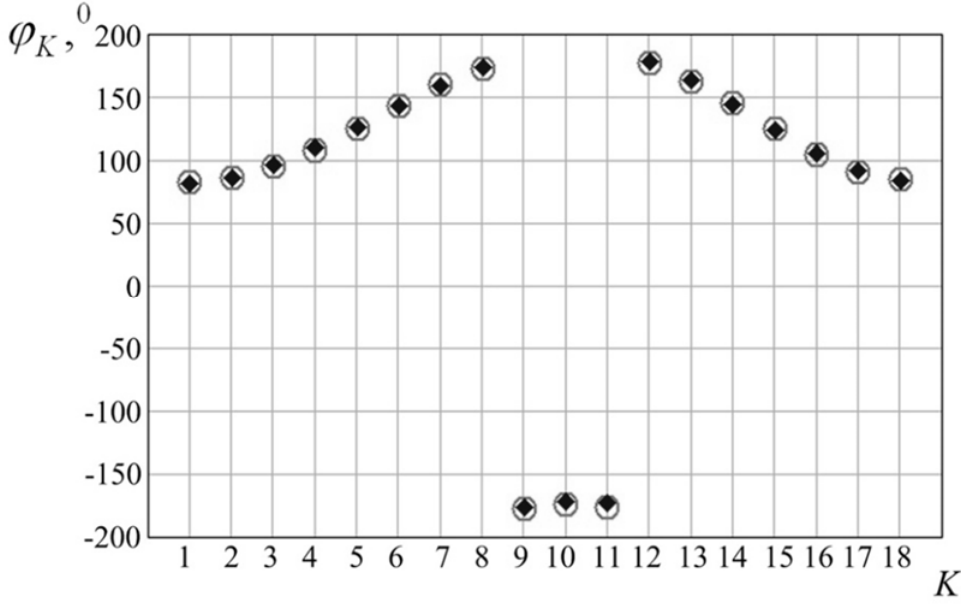
Figure 23. The phase values at points on the radius R 1 = 22.5 mm at f = 1800 MHz.